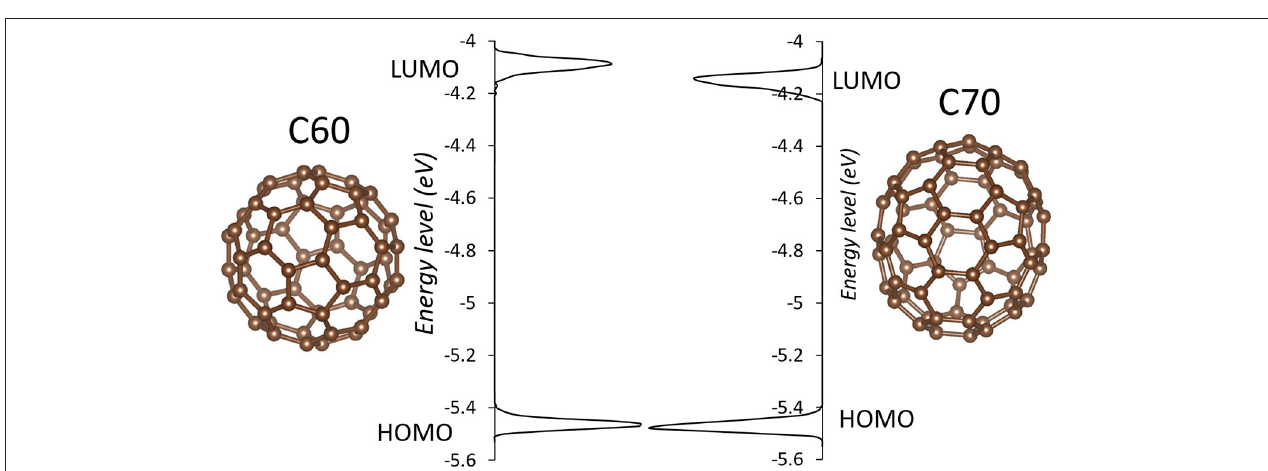
FIGURE 1 | The simulations cells of C60 (left) and C70 (right) .